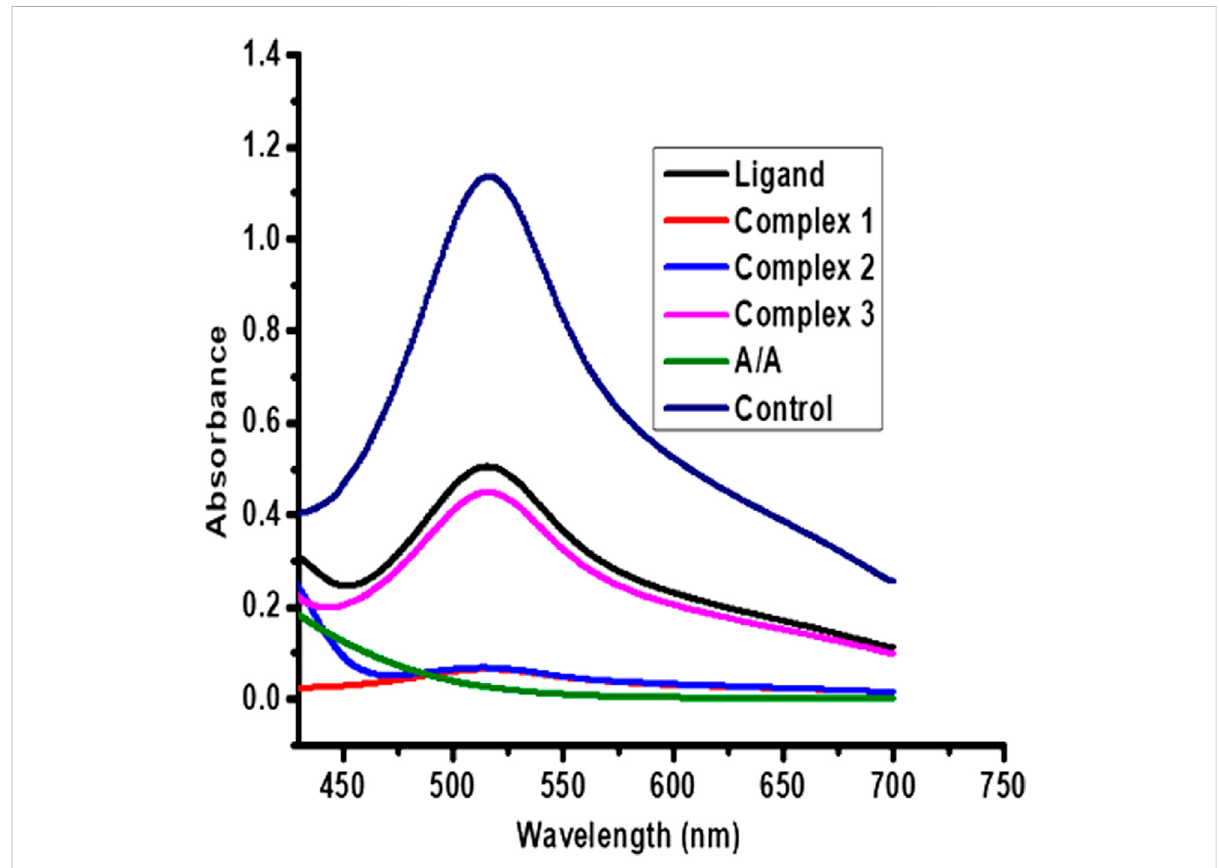
FIGURE 7 Comparison of absorbance of the control, the reference and the